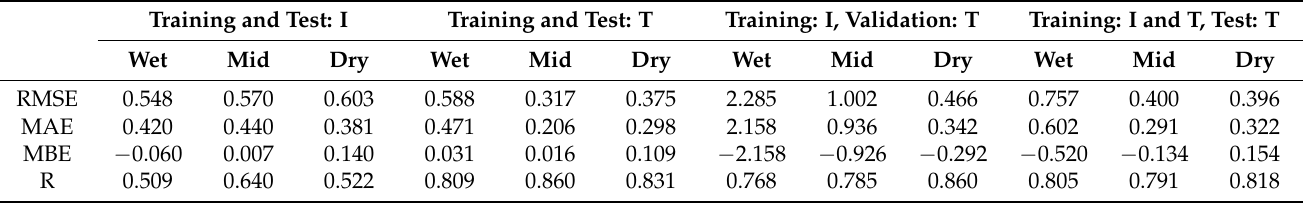
Table 6. Performance of the PC NN -PTFs (inputs: SSC, BD, OM, and pF) developed to estimate the log( K ) at wet (pF ≤ 2) intermediate (2 < pF ≤ 3) and dry (pF > 3) parts of the